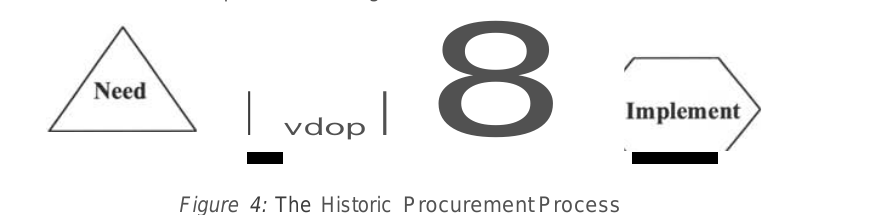
Figure 3: Move from traditional open market negotiation to collaboration (Khalfan et al., 2004)